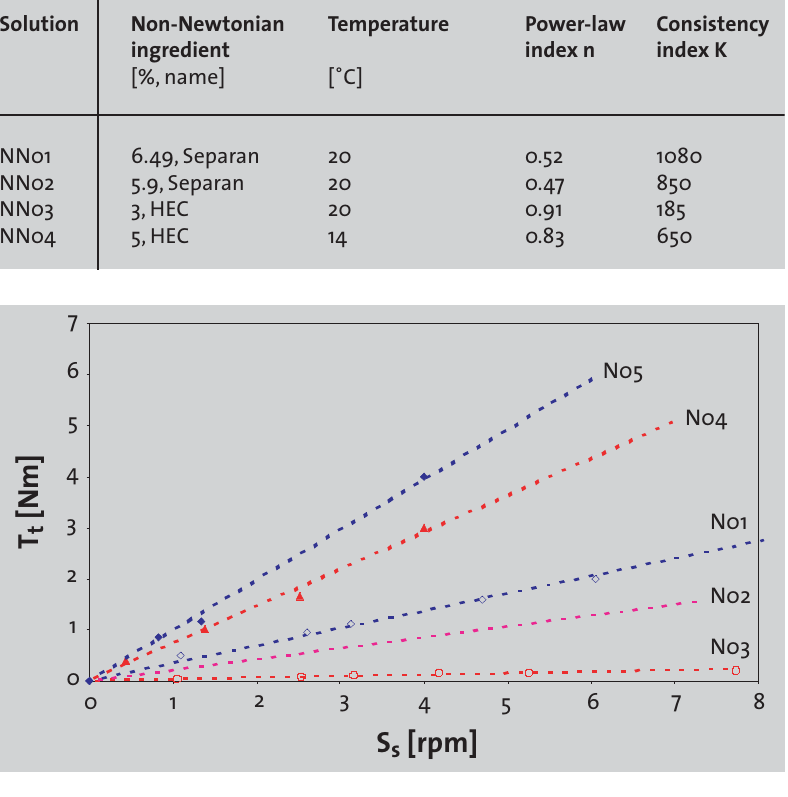
Table 2 (left above): Experimental Fluids, non-Newtonian. Figure 2 (left below): Raw kneader data showing rate of rotation (slow mixing blade) and total measured torque for Newtonian test fluids. Figure 3 (right): Raw kneader data, rpm (slow mixing blade) versus total torque for a) NN01, NN02, and b) NN03,